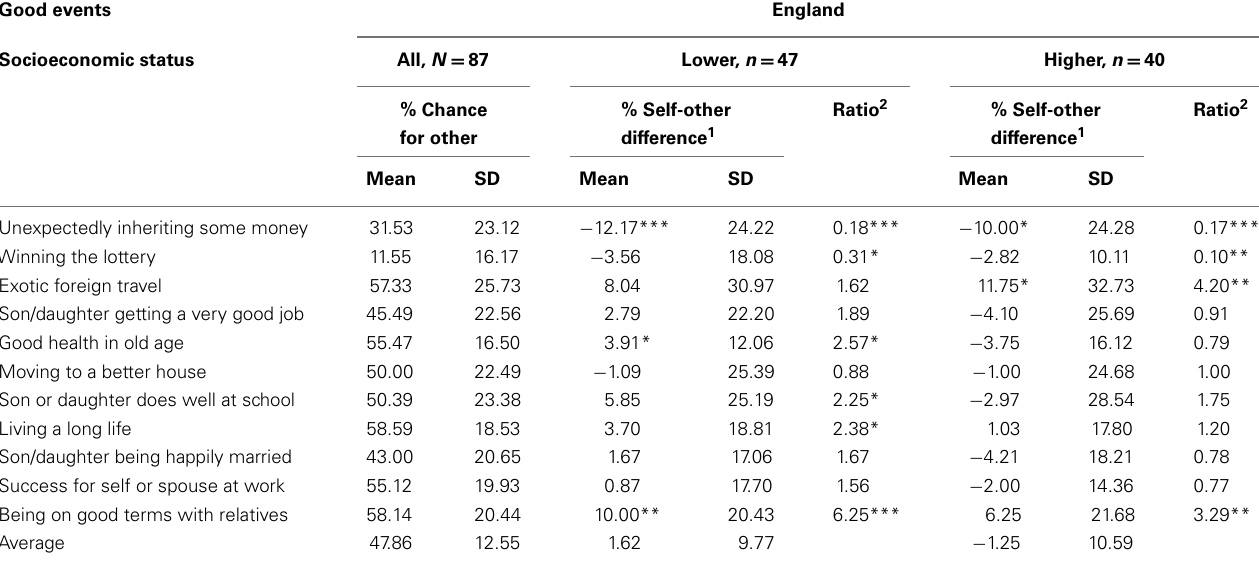
Table 5 | Good events: comparative likelihood estimates,